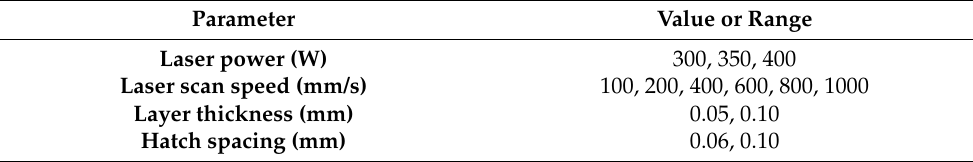
Table 2. SLM parameters and the corresponding value or range to be tested.